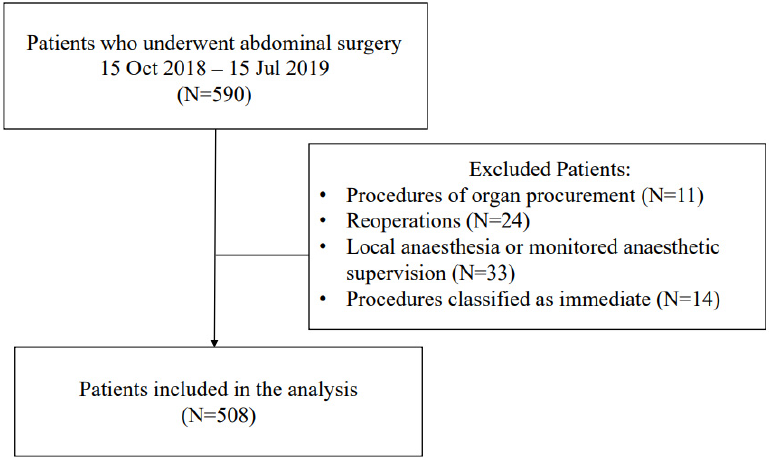
Figure 1. Flow diagram for the patient selection process. The majority of patients had their systolic (SBP) and diastolic blood pressure (DBP) measured on a non-dominant arm with an automated oscillometric non-invasive BP monitoring device (Dräger Infinity Gamma XL) with a cuff of appropriate size depending on the patient’s arm circumference and recorded in five min intervals during anaesthesia from the first pre-induction measurement until the last measurement during recovery from anaesthesia in the operating theatre. MAP values were automatically calculated. For patients with invasive blood pressure monitoring, BP was measured directly. A need for norepinephrine (NE) use, its doses and duration of infusion, together with intraoperative fluid balance, were recorded and